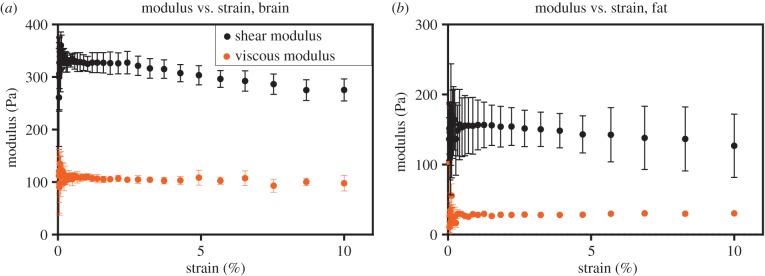
(a) Shear modulus of brain with increasing shear strains. The linear viscoelastic region was determined to be approximately 0.15-2.5% strain. (b) Shear modulus of lean fat with increasing shear strains. The linear viscoelastic region was determined to be 0.15-4% strain.